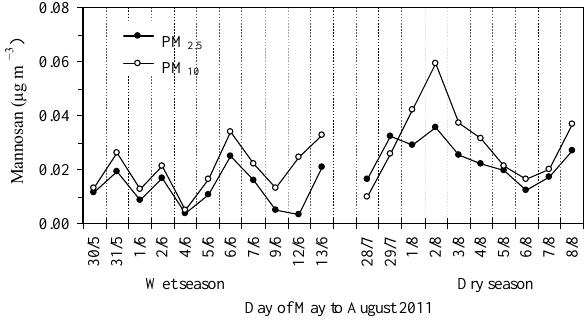
Fig. 7. Temporal variations of mannosan in PM 2 . 5 and PM 10 at Mo- rogoro during the wet and dry seasons.